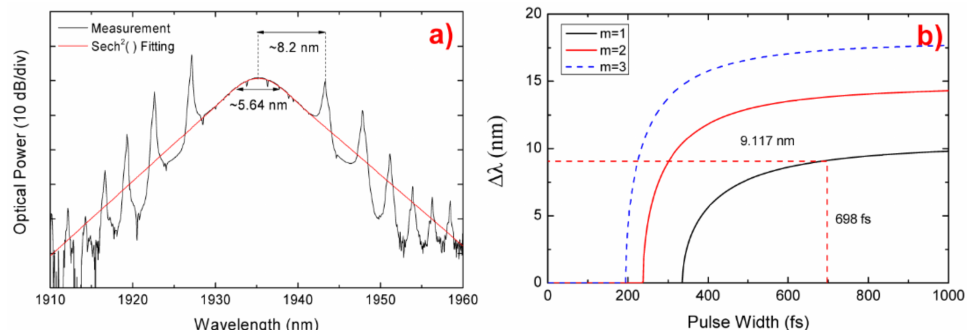
Figure 12. ( a ) Measured optical spectrum of output pulses. ( b ) Theoretically calculated Kelly sideband position relative to the center wavelength ( ∆ λ ) as a function of the temporal width of transform-limited pulses for various Kelly sideband orders (m). Reprinted with permission from